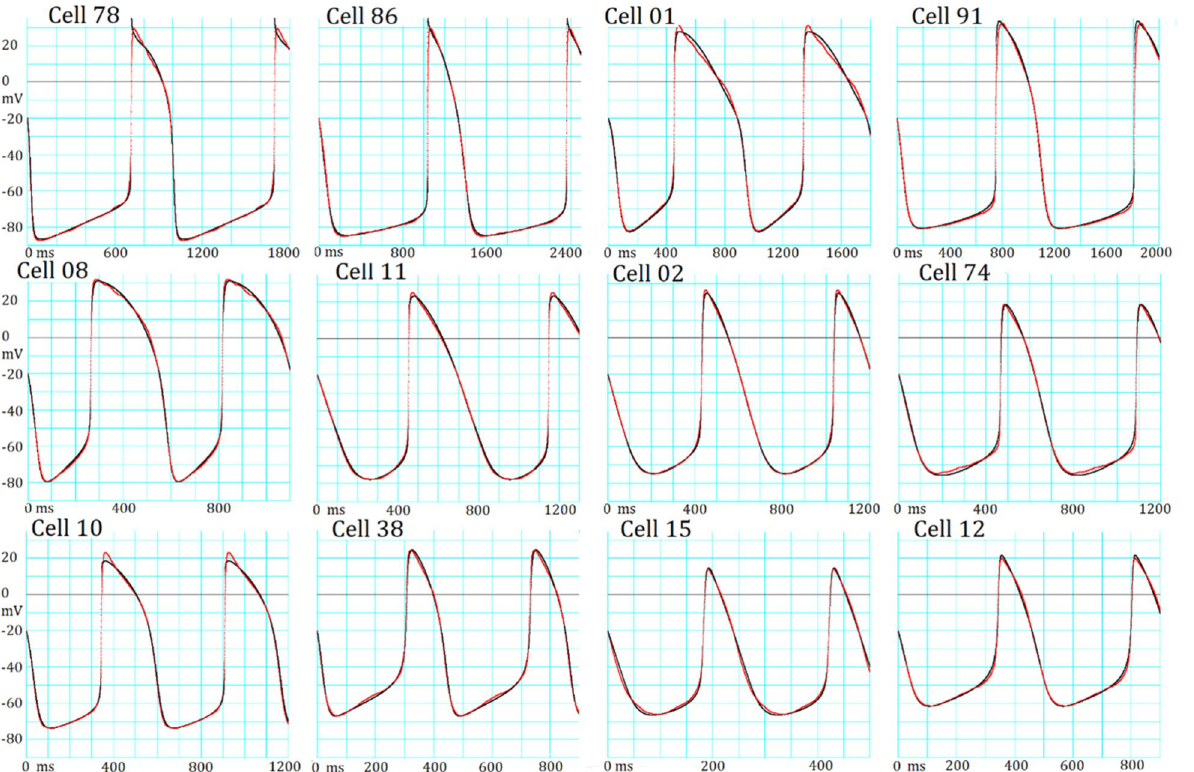
Figure 2. Manual fitting of variable AP configurations in 12 different hiPSC-CMs. Each panel shows the experimental record (red) superimposed by the model output (black) of the baseline model adjusted by the conventional manual fitting. The experimental cell number is presented at the top of each pair of AP records, The extra fluctuations are obvious during the AP plateau in Cells 78, 08, and 01, and during SDD in Cells 15 and 74. The length of abscissa is markedly different to illustrate the interval between two successive peaks of AP.